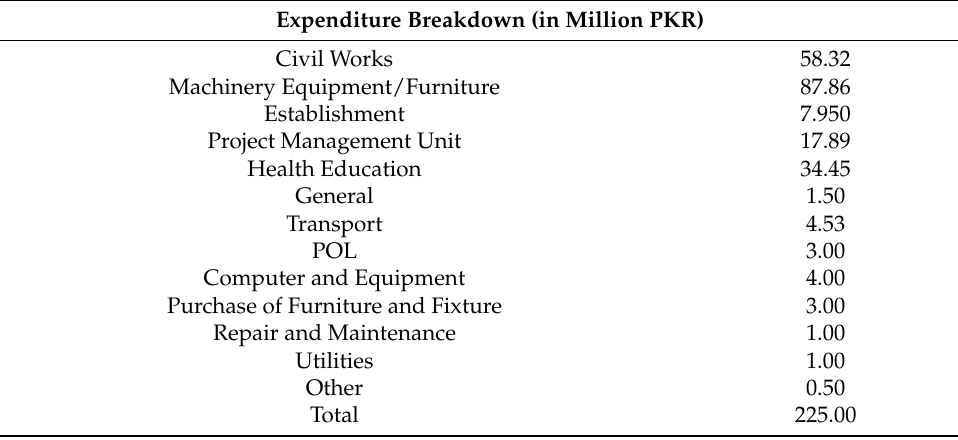
Table 2. The expenditure utilization breakdown in different